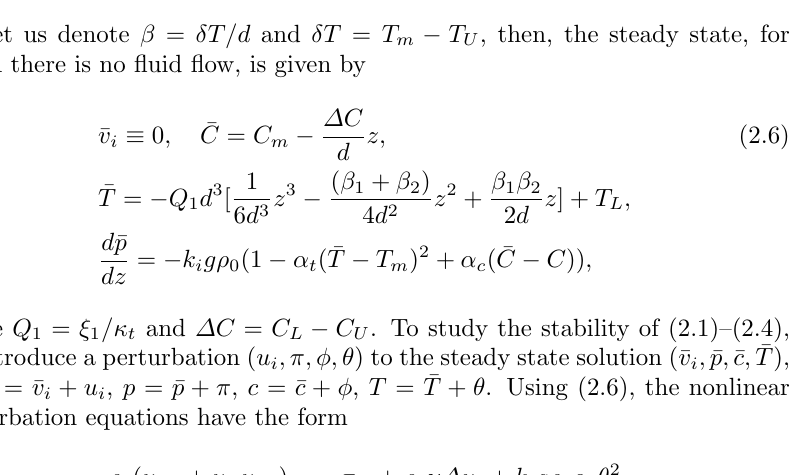
Figure 1. Steady-state temperature